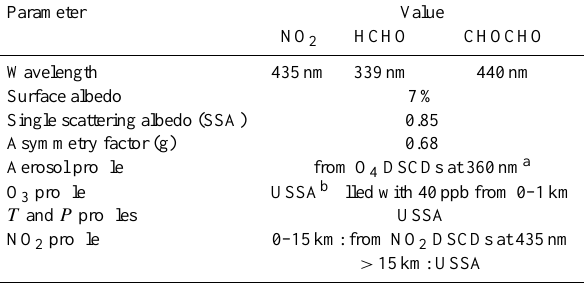
Table 2. Parameter settings of RTM calculations for NO 2 , HCHO, and CHOCHO